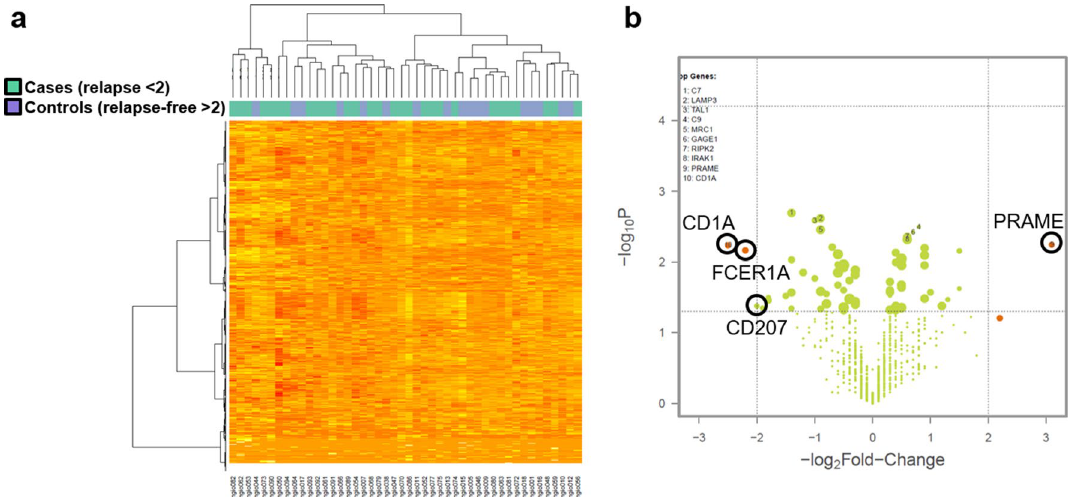
Figure 2. Immune profiling using the nCounter PanCancer Immune Profiling Panel. ( a ) Cluster analysis of normalized nanoString mRNA expression data between short-term (cases, light green boxes on top of heatmap) and long-term relapse-free survivors (controls, light blue boxes). ( b ) Vulcano plot of significantly differentially expressed candidate genes between the patient cohorts ( p value <0.05 und foldchange